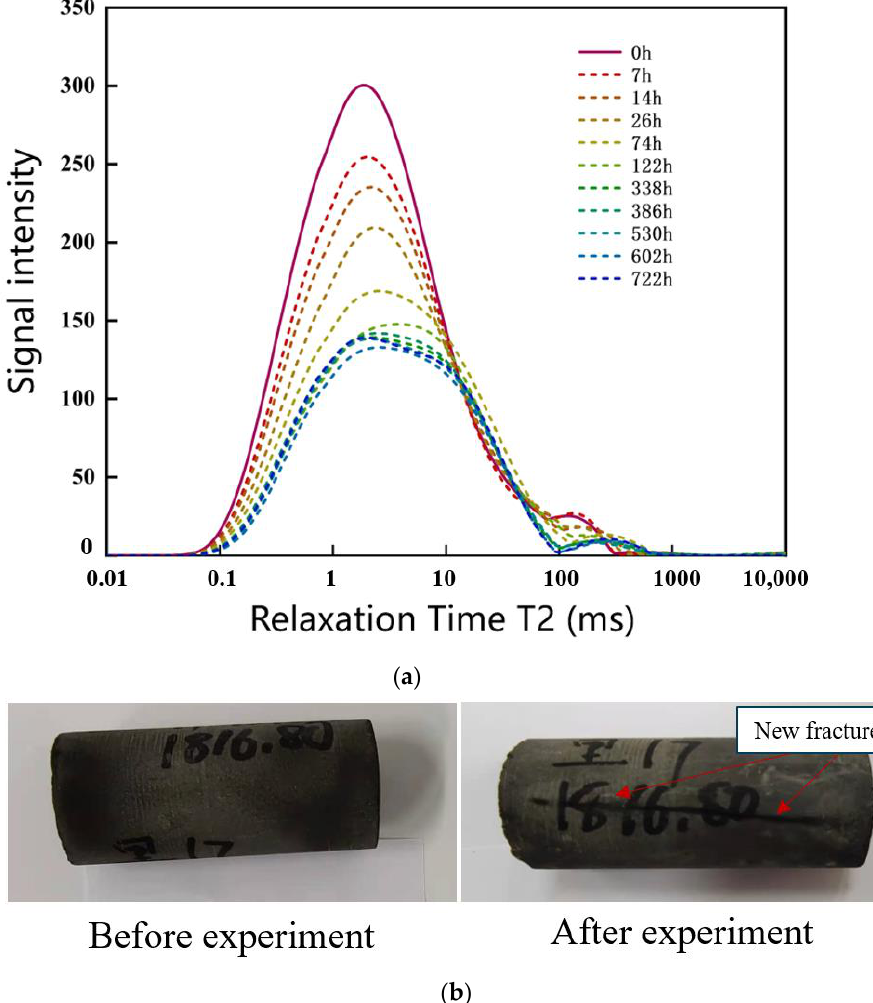
Figure 5. Development of T 2 of sample LYQ at 1 atm. ( a ) The development of T2 with time; ( b ) The new fracture on the surface of the sample after the experiments.